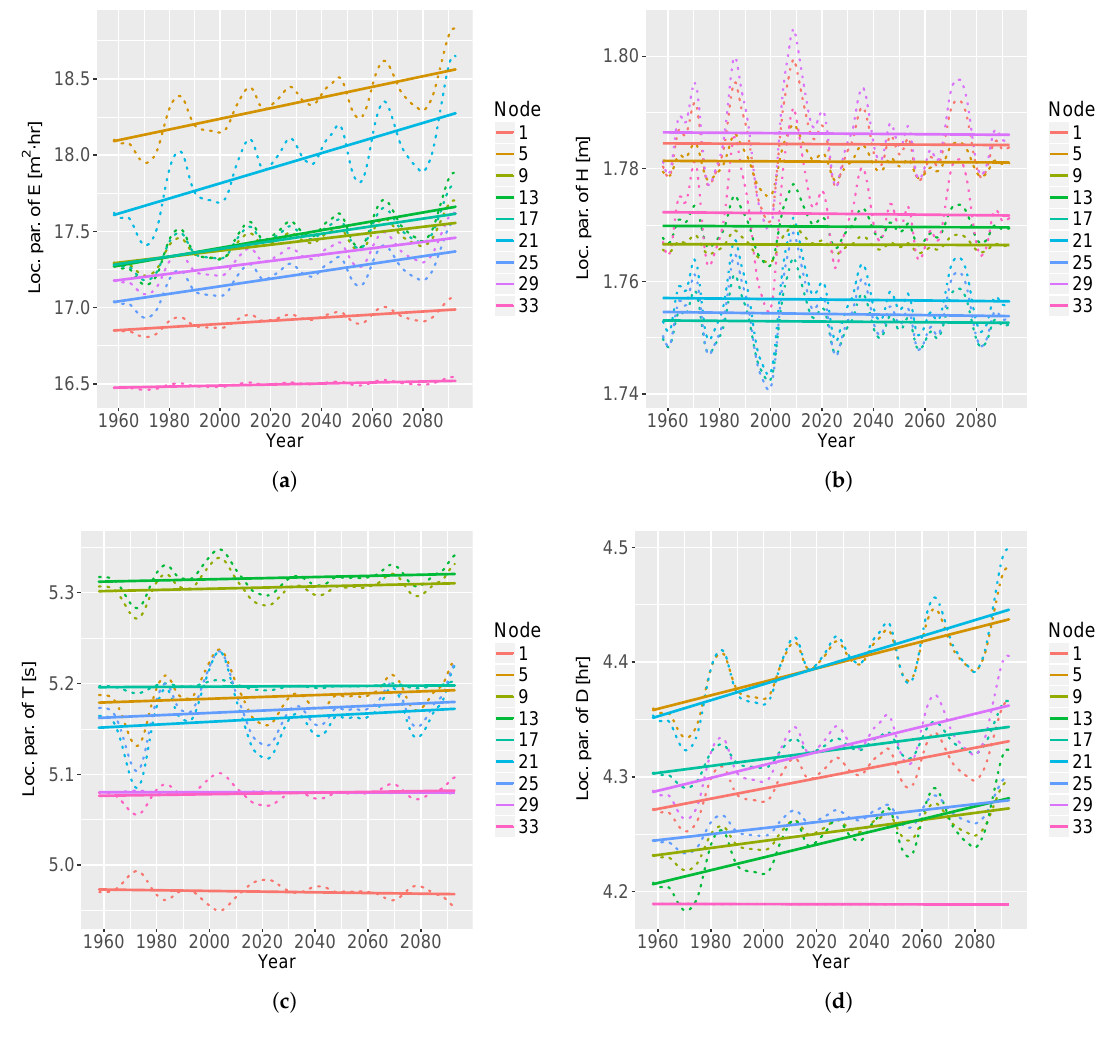
Figure 4. Location parameter x 0 of the generalized Pareto distribution (GPD) that models ( a ) E , ( b ) H p , ( c ) T p , and ( d ) D at selected nodes, under the RCP4.5 scenario. The Eastern Atlantic Pattern (EA) was used in the vectorial generalized additive model (VGAM) to predict the location parameter x 0 of E and D . The first time-derivative of the North Atlantic Oscillation (NAO) was used in the VGAM to predict the location parameter x 0 of H p . The Scandinavian Pattern (SC) was used in the VGAM to predict the location parameter x 0 of T p . The time series are approximated by a straight line, which helps to see the trend of the location parameters x 0 in each